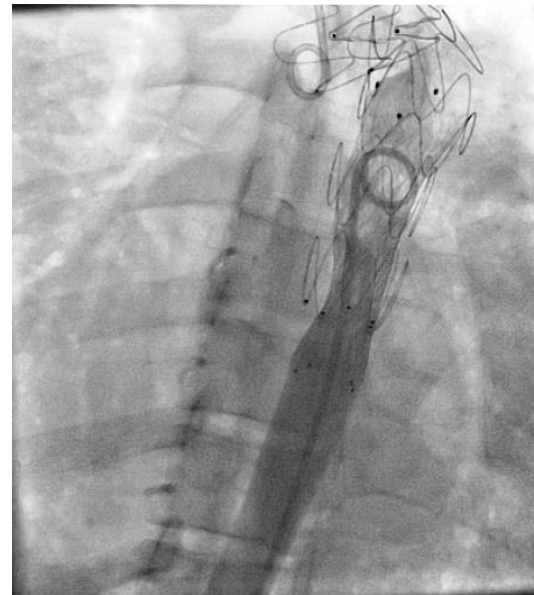
Figure 4B. Descending aortic injection after post-dilation